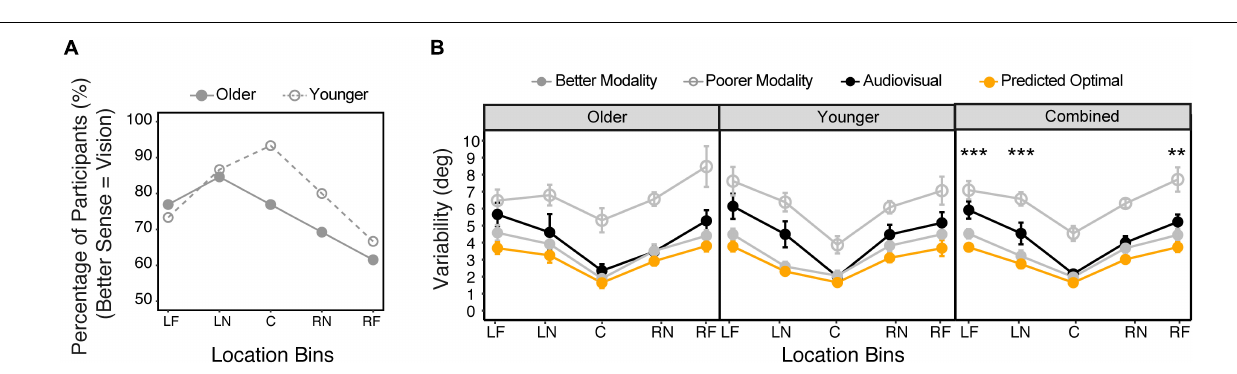
FIGURE 7 | Audiovisual integration. (A) The percentage of subjects who showed vision as the better modality (smaller variability) at each location bin in each group. (B) Comparison between the actual audiovisual variability, predicted optimal variability based on the MLE model, variability of the better modality, and variability of the poorer modality, for the older and younger groups, respectively. The five bins correspond to –90 ◦ to –60 ◦ (LF), –50 ◦ to –20 ◦ (LN), –10 ◦ to 10 ◦ (C), 20 ◦ –50 ◦ (RN), 60 ◦ –90 ◦ (RF). The error bars represent standard errors. Statistical asterisks represent significant difference between the actual audiovisual variability and the predicted optimal variability. *** p < 0.001; ** p <